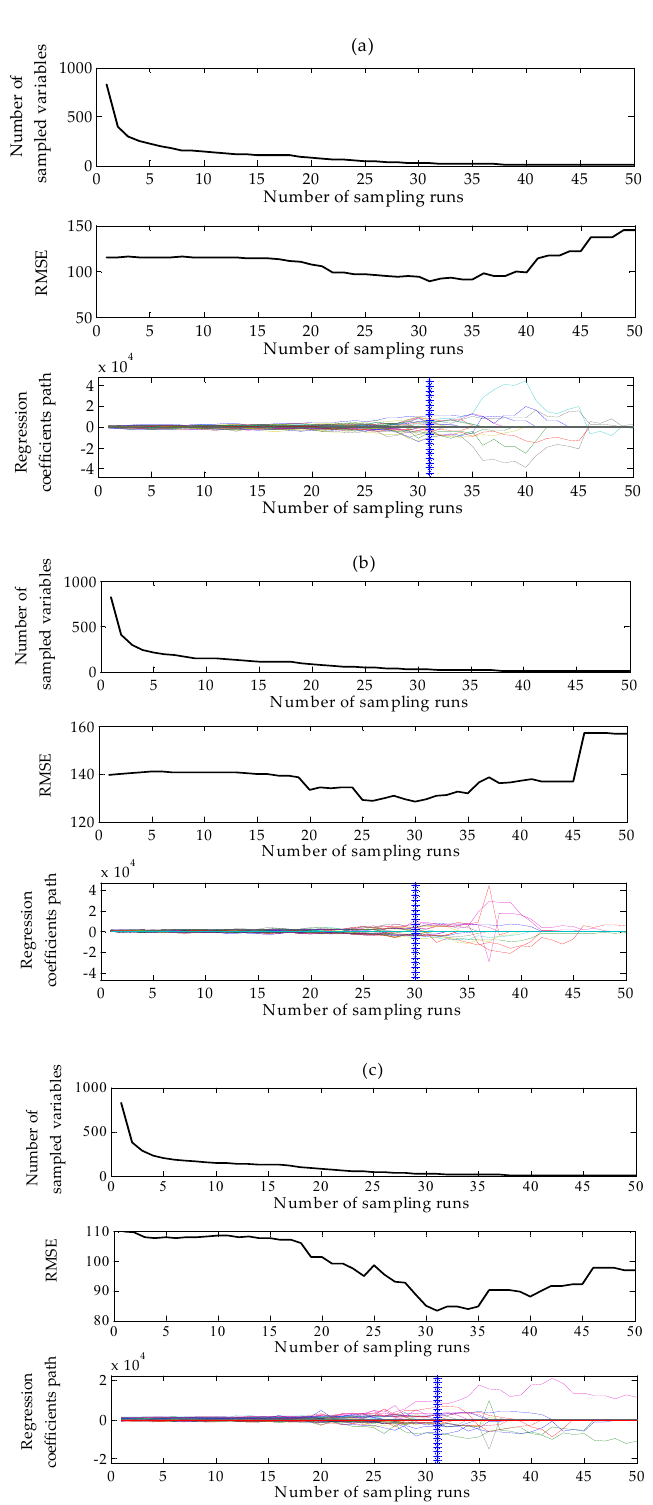
Figure 7. The wavelength selection results obtained from competitive adaptive reweighted sampling (CARS) in ( a ) rapid growth stage of leaf cluster, ( b ) sugar growth stage and ( c ) sugar accumulation stage, shown as changes in the number of selected variables, root mean square error of cross-validation (RMSE) and the regression coe ffi cients path of each variable (di ff erent colored lines refer to the regression coe ffi cient of each wavelength).